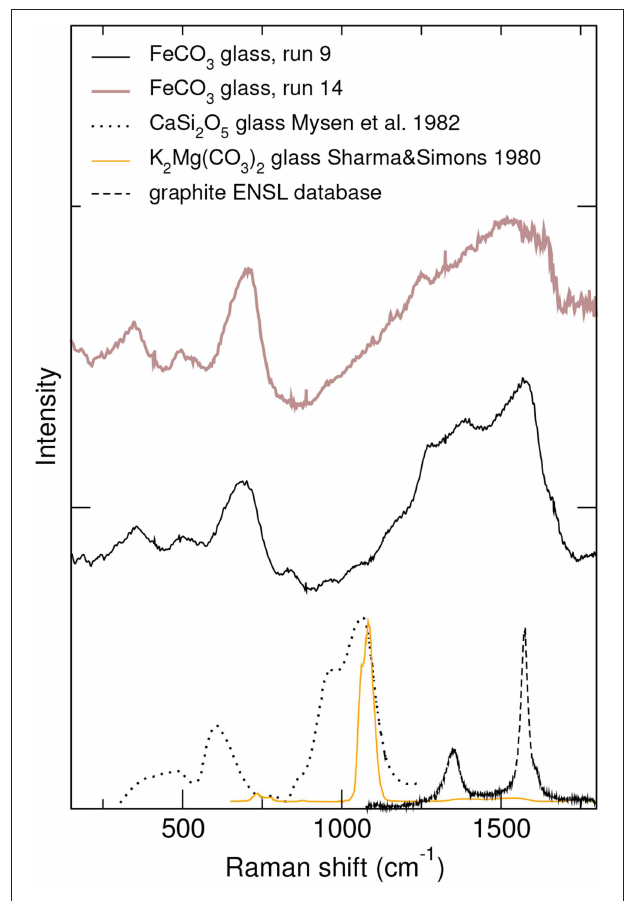
FIGURE 6 | Raman spectra collected on high P -quenched FeCO 3 glasses (runs 9 and 14) at ambient